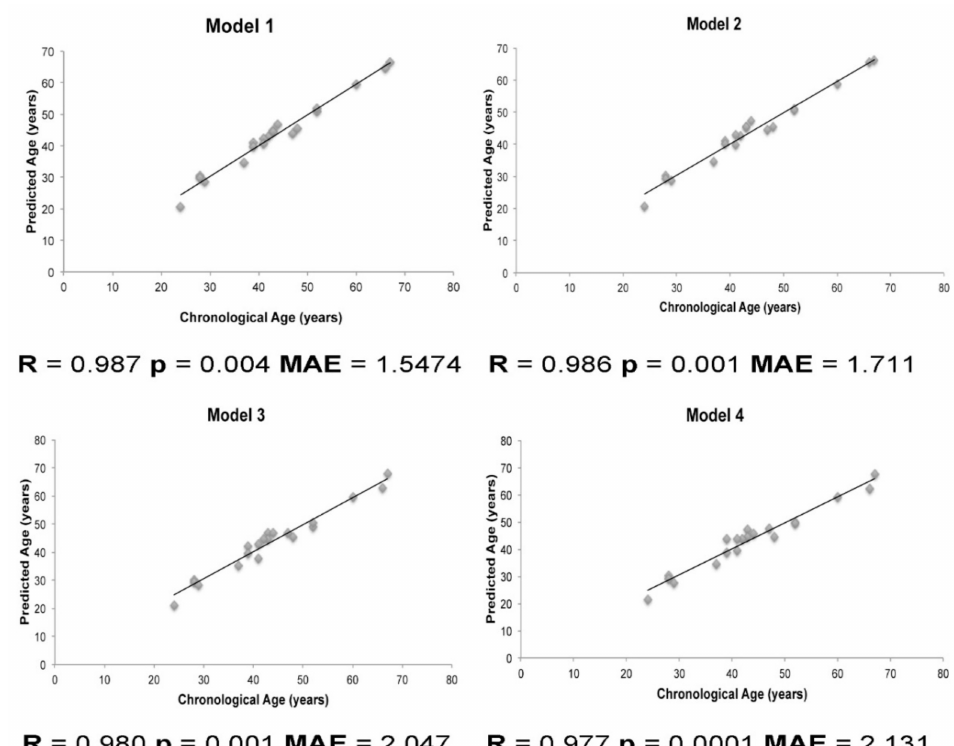
Figure 1. Predicted versus chronological age, determined by each statistical model. The graphs depict the accuracy of each model to predict the age in twenty pulp samples, assessed by Pearson correlations. MAE, Mean Absolute